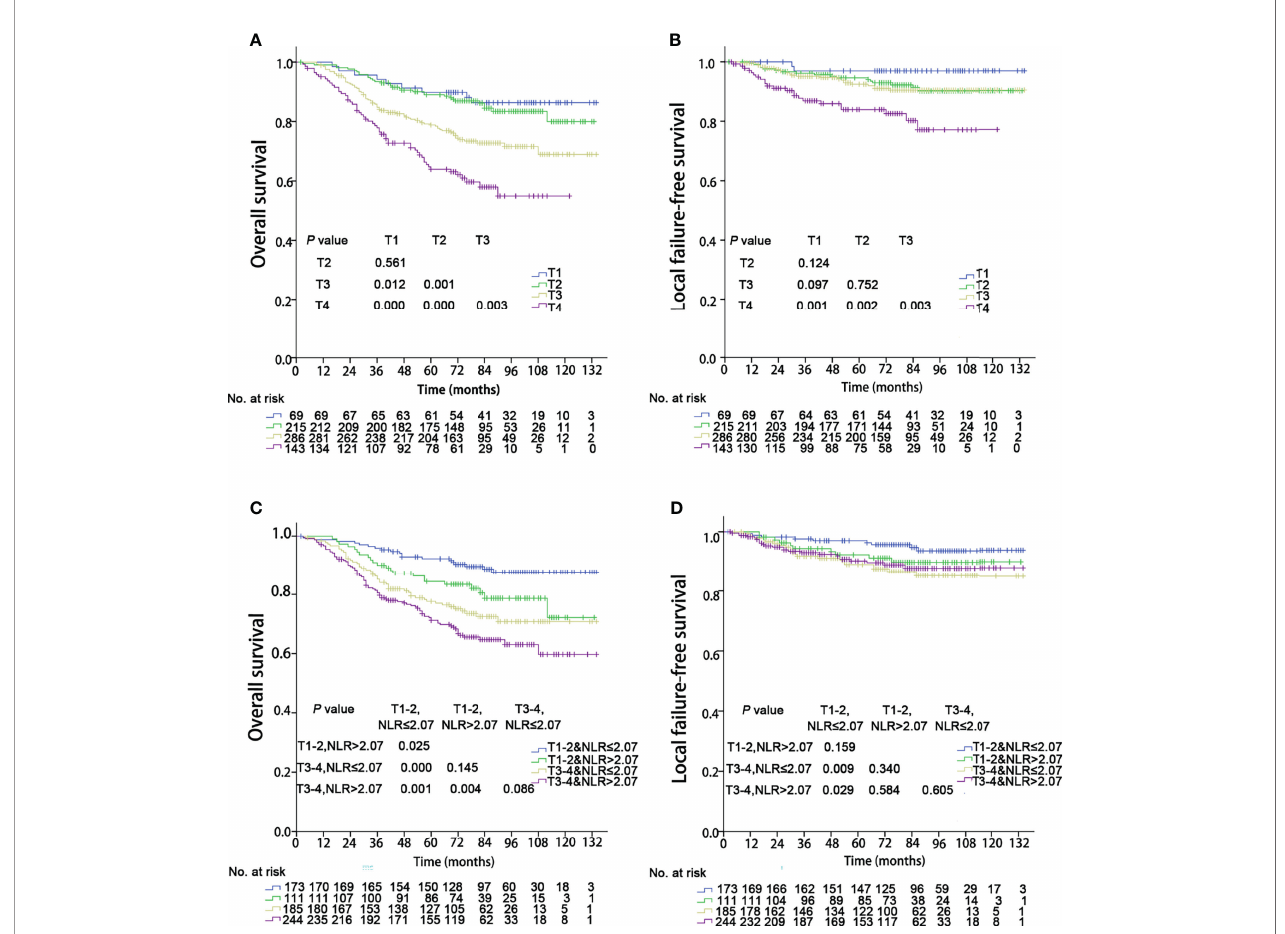
FIGURE 2 | Kaplan – Meier survival curves of 713 patients strati fi ed by the T and T & NLR classi fi cations. NLR, Neutrophil-to-lymphocyte ratio. (A, C) Overall survival; (B, D) Local failure-free